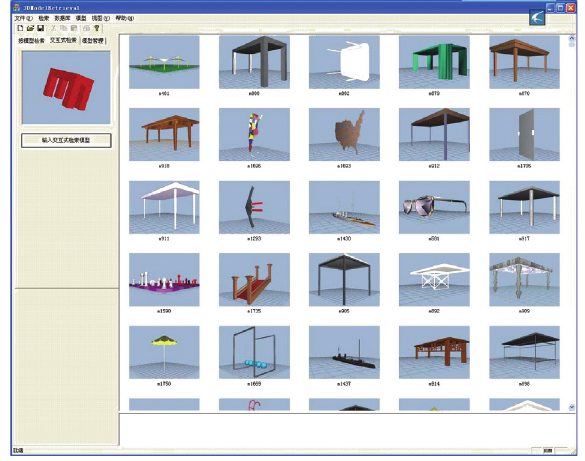
Figure 12: The new experimental result.